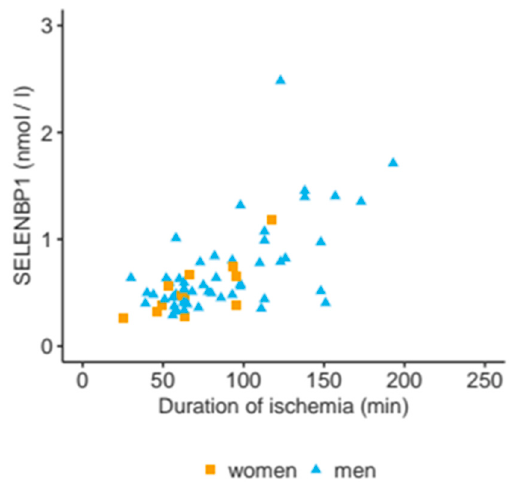
Figure 4. Correlation of serum SELENBP1 concentrations with duration of ischemia. Serum SELENBP1 concentrations were determined at 15 min after weaning from the CBP and are displayed in relation to duration of ischemia. A linear correlation is observed ( ρ = 0.6, p < 0.0001).